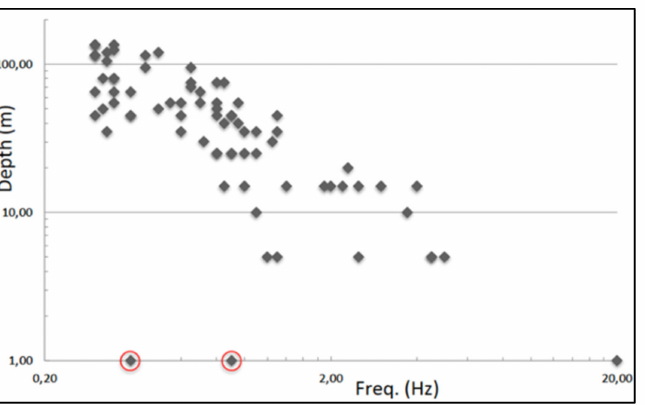
Figure 16. Fundamental frequency (f o ) in relation to the depth-to-bedrock based on the 76 HVSRs and the underlying bedrock of the Durres basin. In red circles flat HVSRs are depicted.